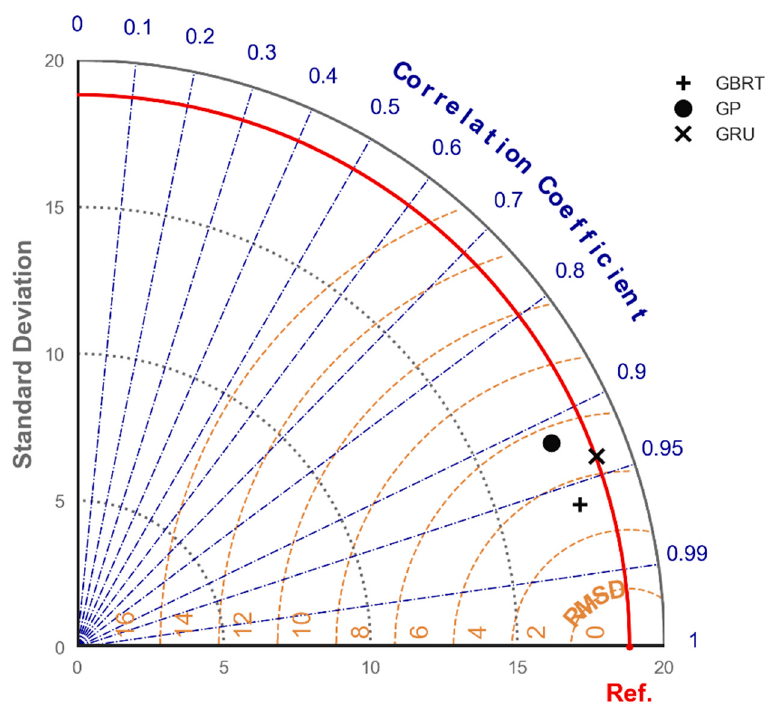
Figure 11. Taylor diagram comparing performance of three developed ML models.